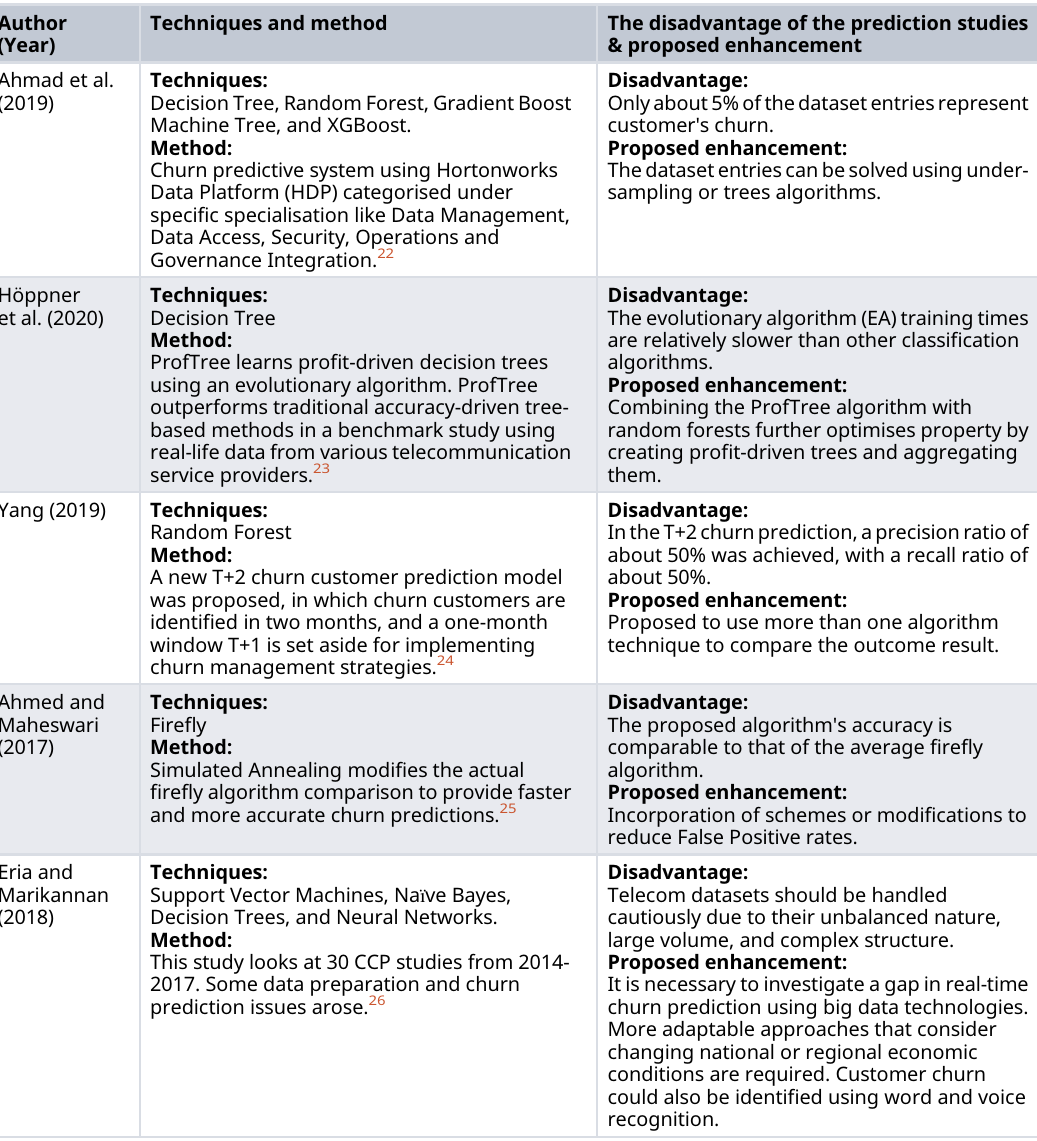
Table 2. A summary of churn prediction